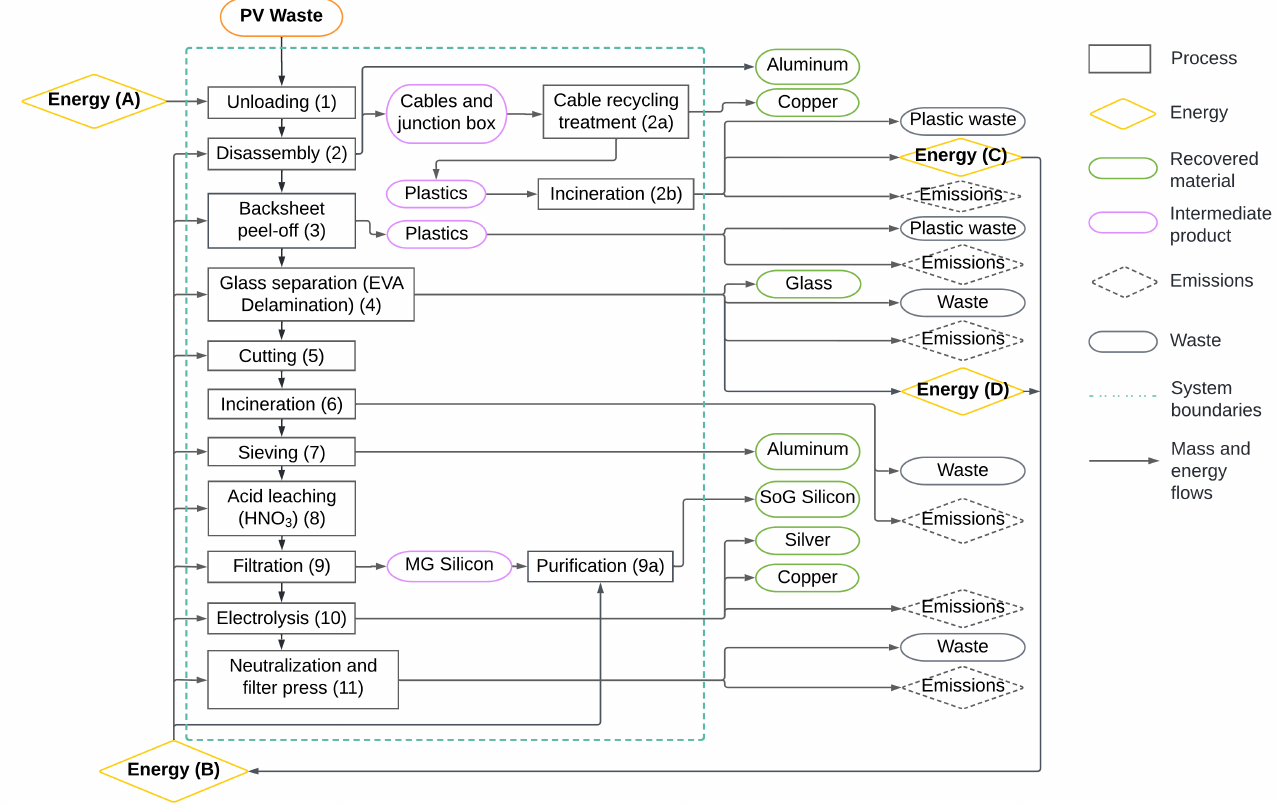
Figure 2. Specific recycling system considered for this